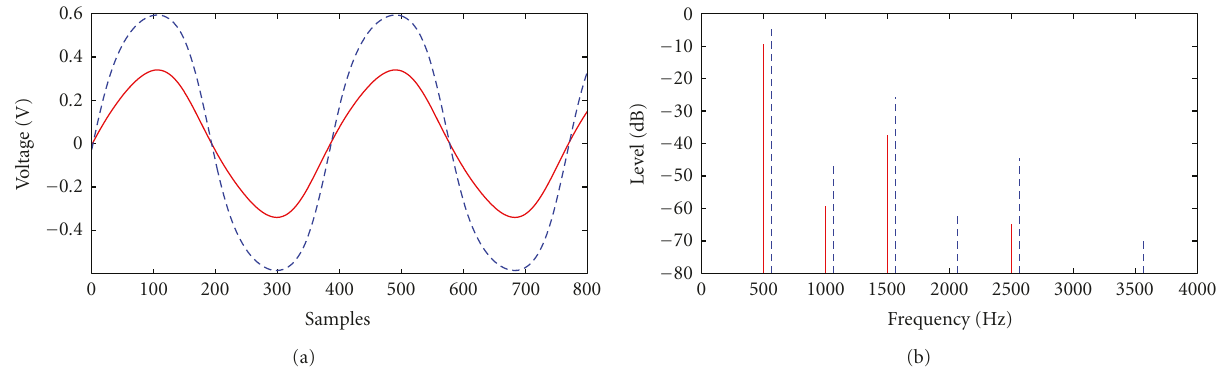
Figure 7: Comparison between the real-world output of pedal 1 (blue-dashed) and the GPH model-based output (red-solid) in time (a) and frequency (b) domains, for a sine wave excitation with f 0 = 500 Hz and A 0 = 0 . 5 V. The GPH model is estimated using a swept sine signal with amplitude A s = 1 V. For the sake of clarity, the output of the real-world device in the frequency domain is shifted to the right.